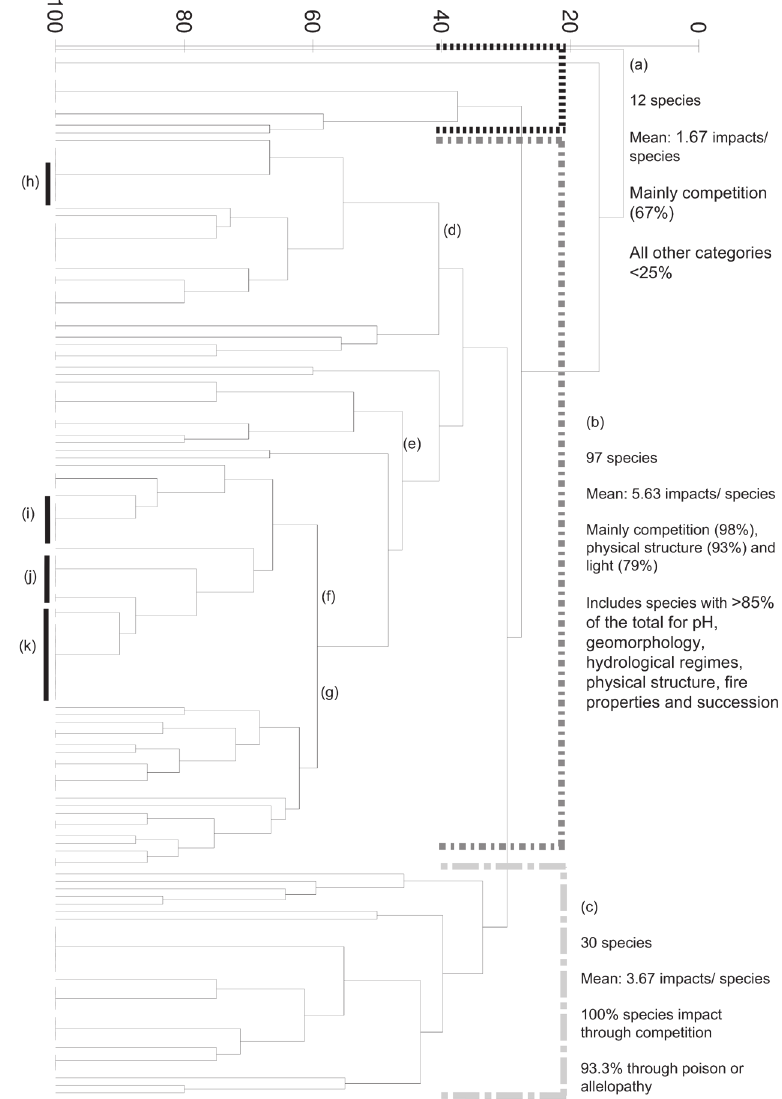
Figure 4. Cladogram of plant impacts, based on similarities of impact types. Mean number and type of impacts have been calculated per clade (Groups a–c ). Sub-groups include d 24 species (Mean: 3 impacts/ species; 100% competition; physical structure 100%) e 11 species (Mean: 4.6 impacts/species; 100% com- petition; physical structure 100%; 82% hydrological) f 32 species (Mean: 7.9 impacts/species; competi- tion, physical structure, light, hydrology, fire >90%) g 22 species (Mean: 6.4 impacts/species; competition, physical structure, light, hydrology >90%). The vertical black bars indicate clustering of species, whereas all other species are scattered across the groups h Cereus jamacaru , Echinopsis spachiana , Opuntia aurantiaca , O. ficus-indica , O. humifusa , Cylindropuntia imbricata , C. fulgida , Opuntia stricta i Eucalyptus cladocalyx , E. lehmannii , E. sideroxylon , E. camaldulensis , E. diversicolor j Pinus radiata , P. roxburghii , P. taeda , P. halepensis , P. patula , P. canariensis , P. pinaster k Acacia dealbata , A. mearnsii , A. melanoxylon , A. paradoxa , A. podalyri- ifolia , A. pycnantha , A. saligna , A. baileyana , A. cyclops , A. decurrens , A. elata , A. implexa , A. longifolia